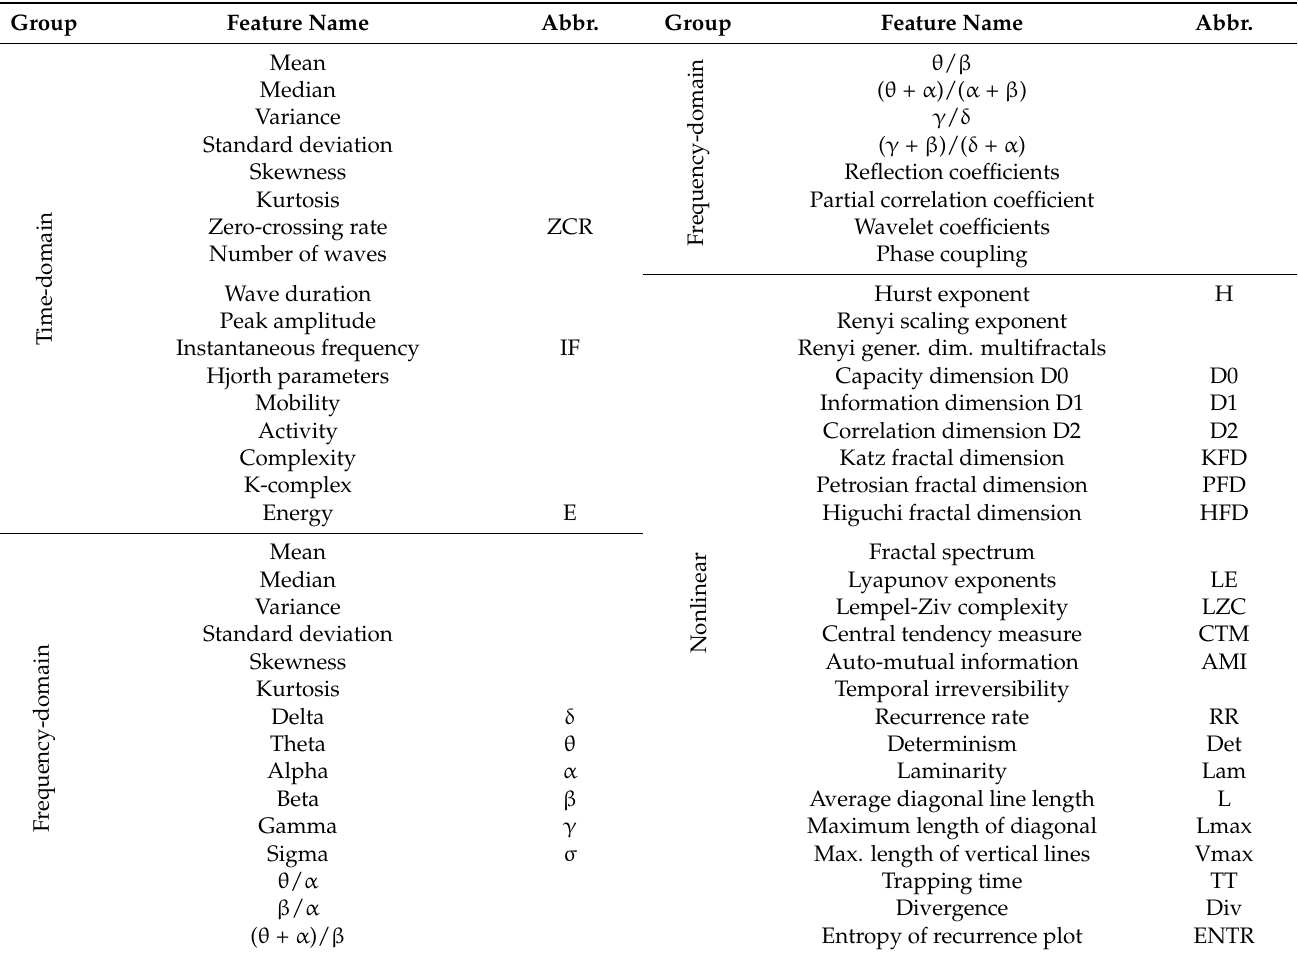
Table 1. The list of time-domain, frequency domain and nonlinear features reviewed in this work.